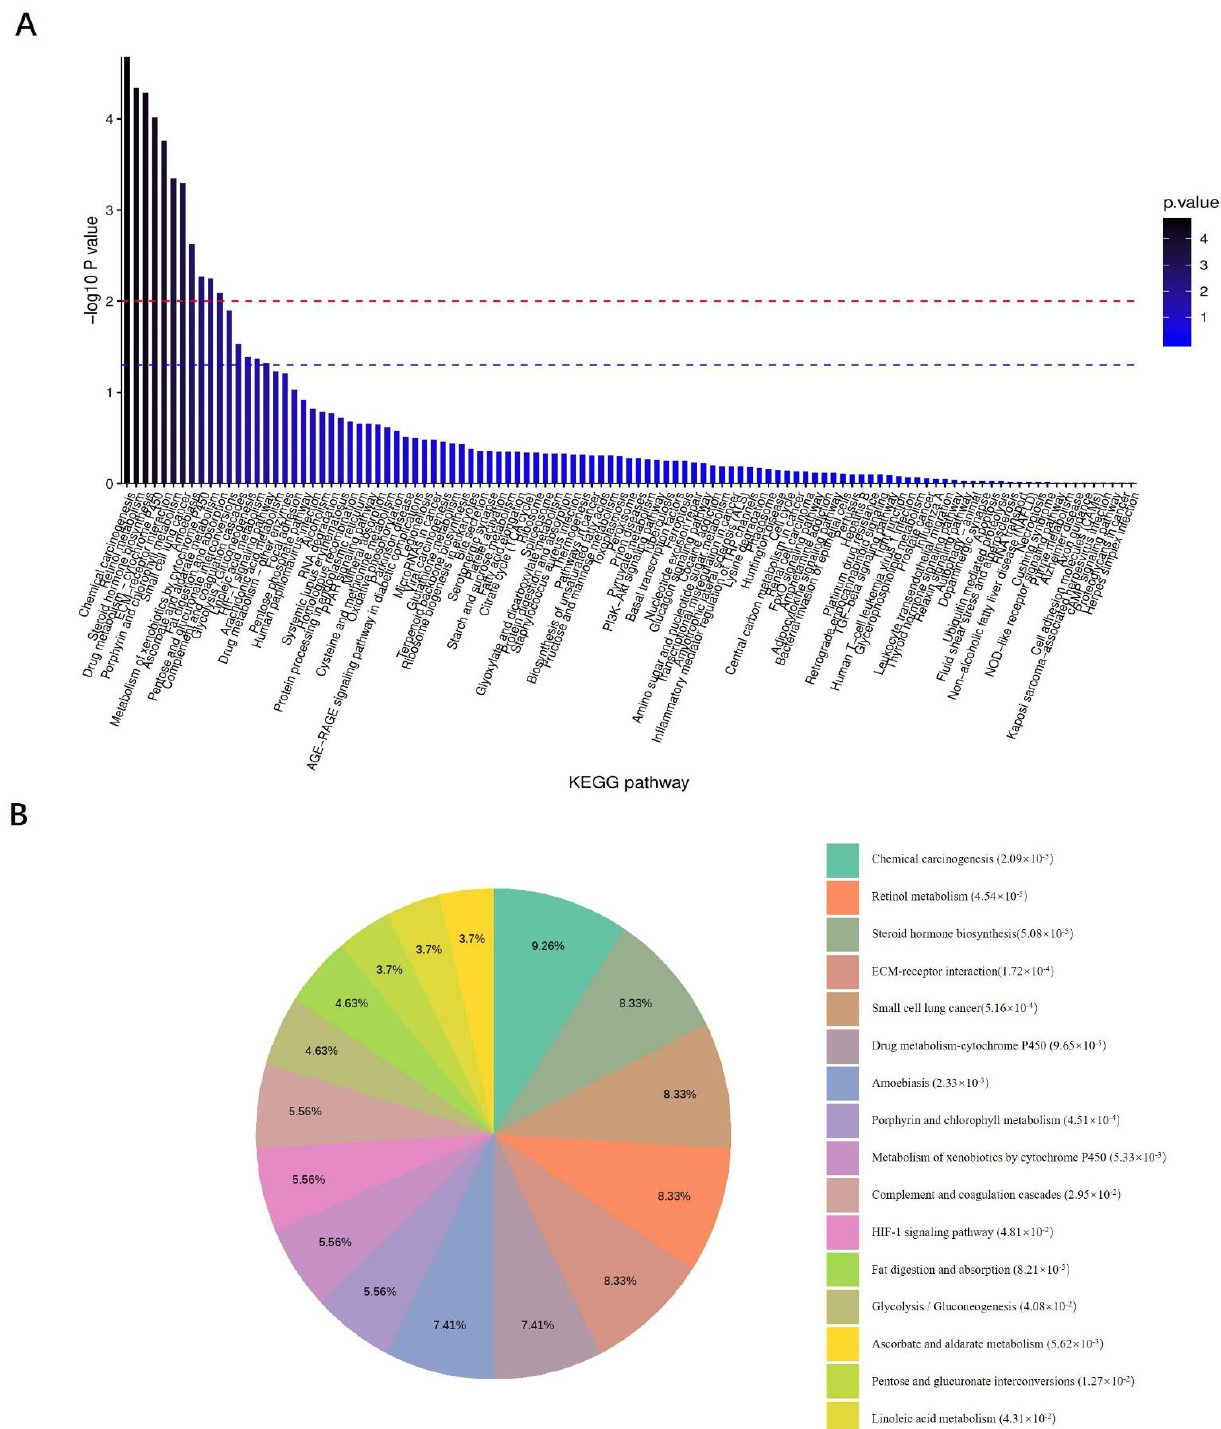
Figure 6. KEGG enrichment analysis of all DEPs obtained from the combination of the Lm 10403s infection group and the Lm M7 infection group. All differentially expressed proteins in the Lm 10403s infection group and the Lm M7 infection group were put together for KEGG analysis. ( A ) Columnar section of the KEGG enrichment analysis results. ( B ) Pie chart of the KEGG enrichment analysis results.